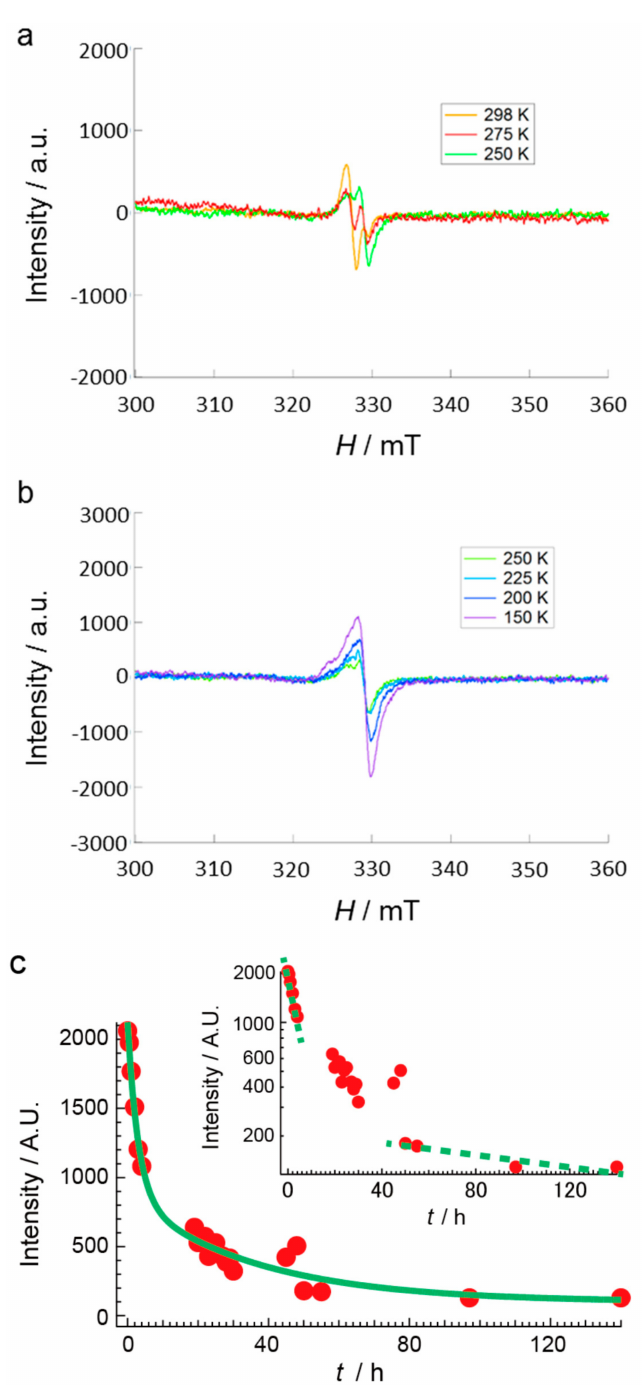
Figure 17. The X-band (9.3 GHz) electron spin resonance (ESR) measured using the single crystal of 1 . The magnetic field was applied in the direction of the a -axis of the single crystal, and the UV was irradiated on the ab -plane of the single crystal. Temperature-dependencies of the spectra under UV-irradiation at ( a ) 298 K, 275 K, and 250 K, and at ( b ) 250 K, 200 K, and 150 K. The spectrum at 250 K appears in di ff erent panels for comparison of signal intensity. ( c ) Time-dependence of electron spin resonance (ESR) signal intensity after cessation of UV-irradiation at 298 K. (Main panel) Intensity vs. Time ( t / h) plot. Red circles and the green curve designate observed and fitting data using a two-component exponential decay model, respectively. (Inset) log(Intensity) vs. Time ( t / h) plot. Red circles and two green broken lines designate observed and fitting data using a two-component exponential decay model, respectively. The inset clearly shows that there are fast and slow processes in the observed relaxation. Reproduced from Ref. [13] with permission from the Royal Society of